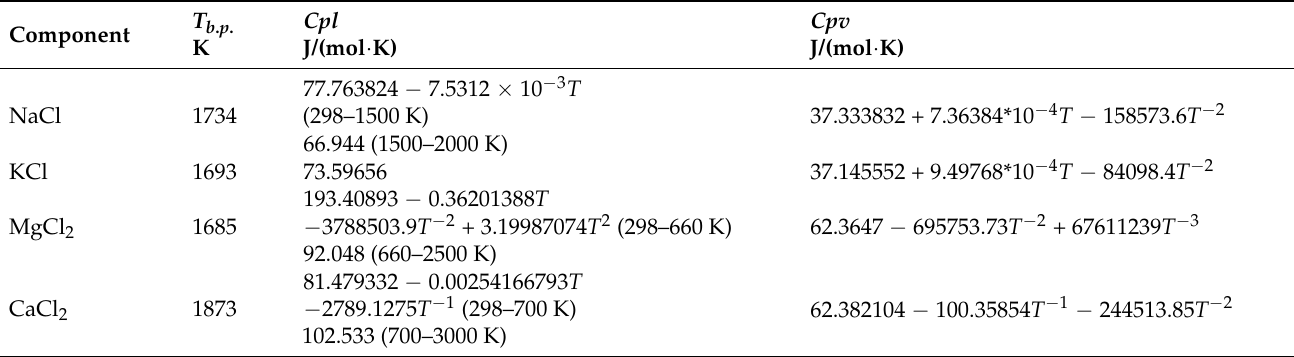
Table 7. Physical parameters for the pure salts obtained from